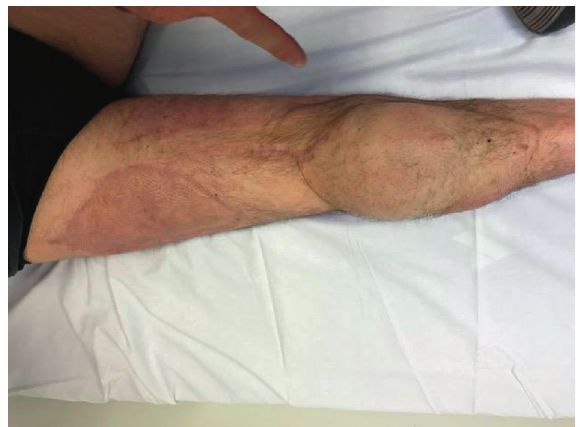
Figure 1: The patient after right leg ipsilateral free ALT flap